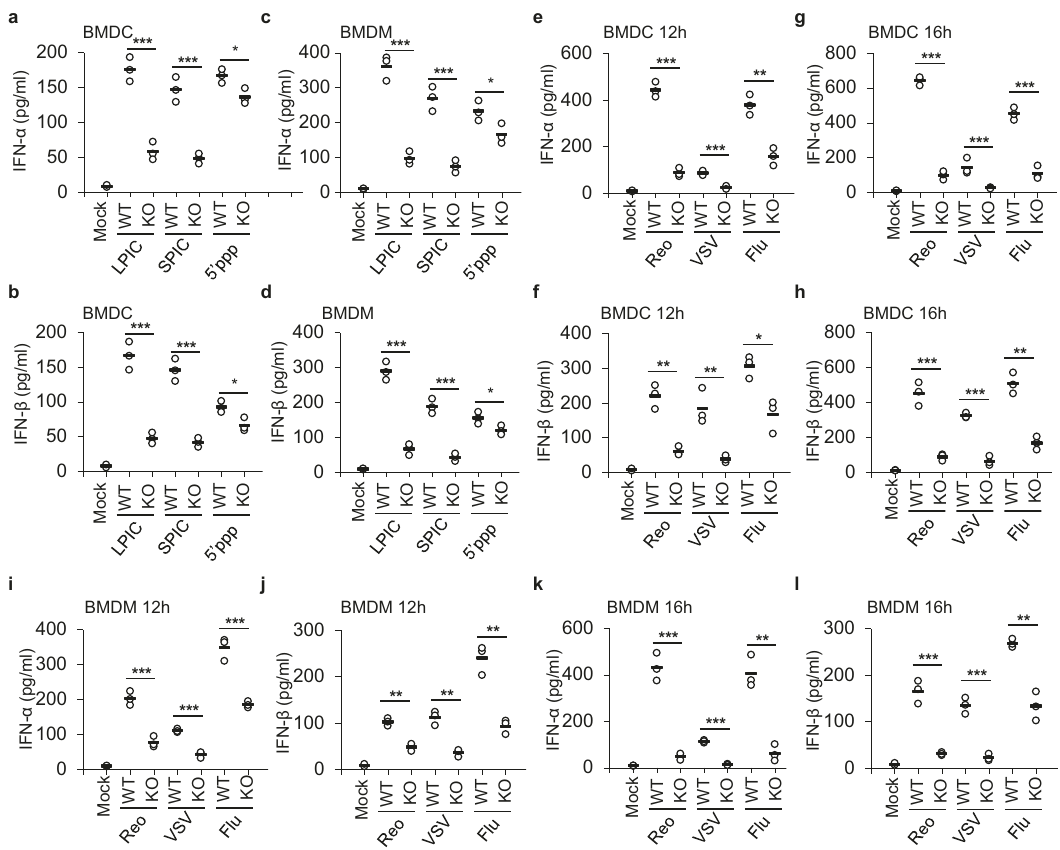
Fig. 2 PARP9 plays an essential role in type I IFN production in response to infection by RNA viruses. ELISA of IFN- α ( a , c ) and IFN- β ( b , d ) production by BMDC ( a , b ) or BMDM ( c , d ) from wild-type (WT) and Parp9 − / − (KO) mice after 10 h of stimulation with long poly I:C (LPIC, 0.5 μ g/ml), short poly I:C (SPIC, 0.5 μ g/ml) and 5 ’ pppRNA (5 ’ ppp, 0.5 μ g/ml) delivered by Lipofectamine 3000 ( n = 3 per group). ELISA of IFN- α ( e , g ) and IFN- β ( f , h ) production by BMDC from wild-type (WT) and Parp9 − / − (KO) mice after 12 h ( e , f ) or 16 h ( g , h ) of infection with Reovirus (Reovirus type 3 strain dearing T3D, Reo), VSV (Vesicular stomatitis virus Indiana strain, VSV) or in fl uenza A virus (in fl uenza A virus PR8 strain, Flu) ( n = 3 per group). ELISA of IFN- α ( i , k ) and IFN- β ( j , l ) production by BMDM from wild-type (WT) and Parp9 − / − (KO) mice after 12 h ( i , j ) or 16 h ( k , l ) of infection with Reovirus, VSV or Flu virus at an MOI of 5 ( n = 3 per group). Each circle represents an individual independent experiment and small solid black lines indicate the average of triplicates for results in a – l . * p < 0.05, ** p < 0.01, *** p < 0.001, and p value was calculated by unpaired two-tailed Student ’ s t test. Mock, wild-type BMDC or BMDM without stimulation or infection. Data are representative of three independent experiments. Exact p values ( a , p = 0.00072, p = 0.00088, p = 0.112; b , p = 0.00069, p = 0.00048, p = 0.0495; c , p = 0.00036, p = 0.00098, p = 0.0495; d , p = 0.00023, p = 0.00044, p = 0.0495; e , p = 0.00008, p = 0.00079, p = 0.0025; f , p = 0.0017, p = 0.0081, p = 0.0136; g , p = 0.00001, p = 0.00098, p = 0.00036; h , p = 0.00089, p = 0.00013, p = 0.0012; i , p = 0.00036, p = 0.00002, p = 0.00004; j , p = 0.0012, p = 0.0015, p = 0.002; k , p = 0.00043, p = 0.00001, p = 0.0019; l , p = 0.00075, p = 0.00052, p = 0.002).